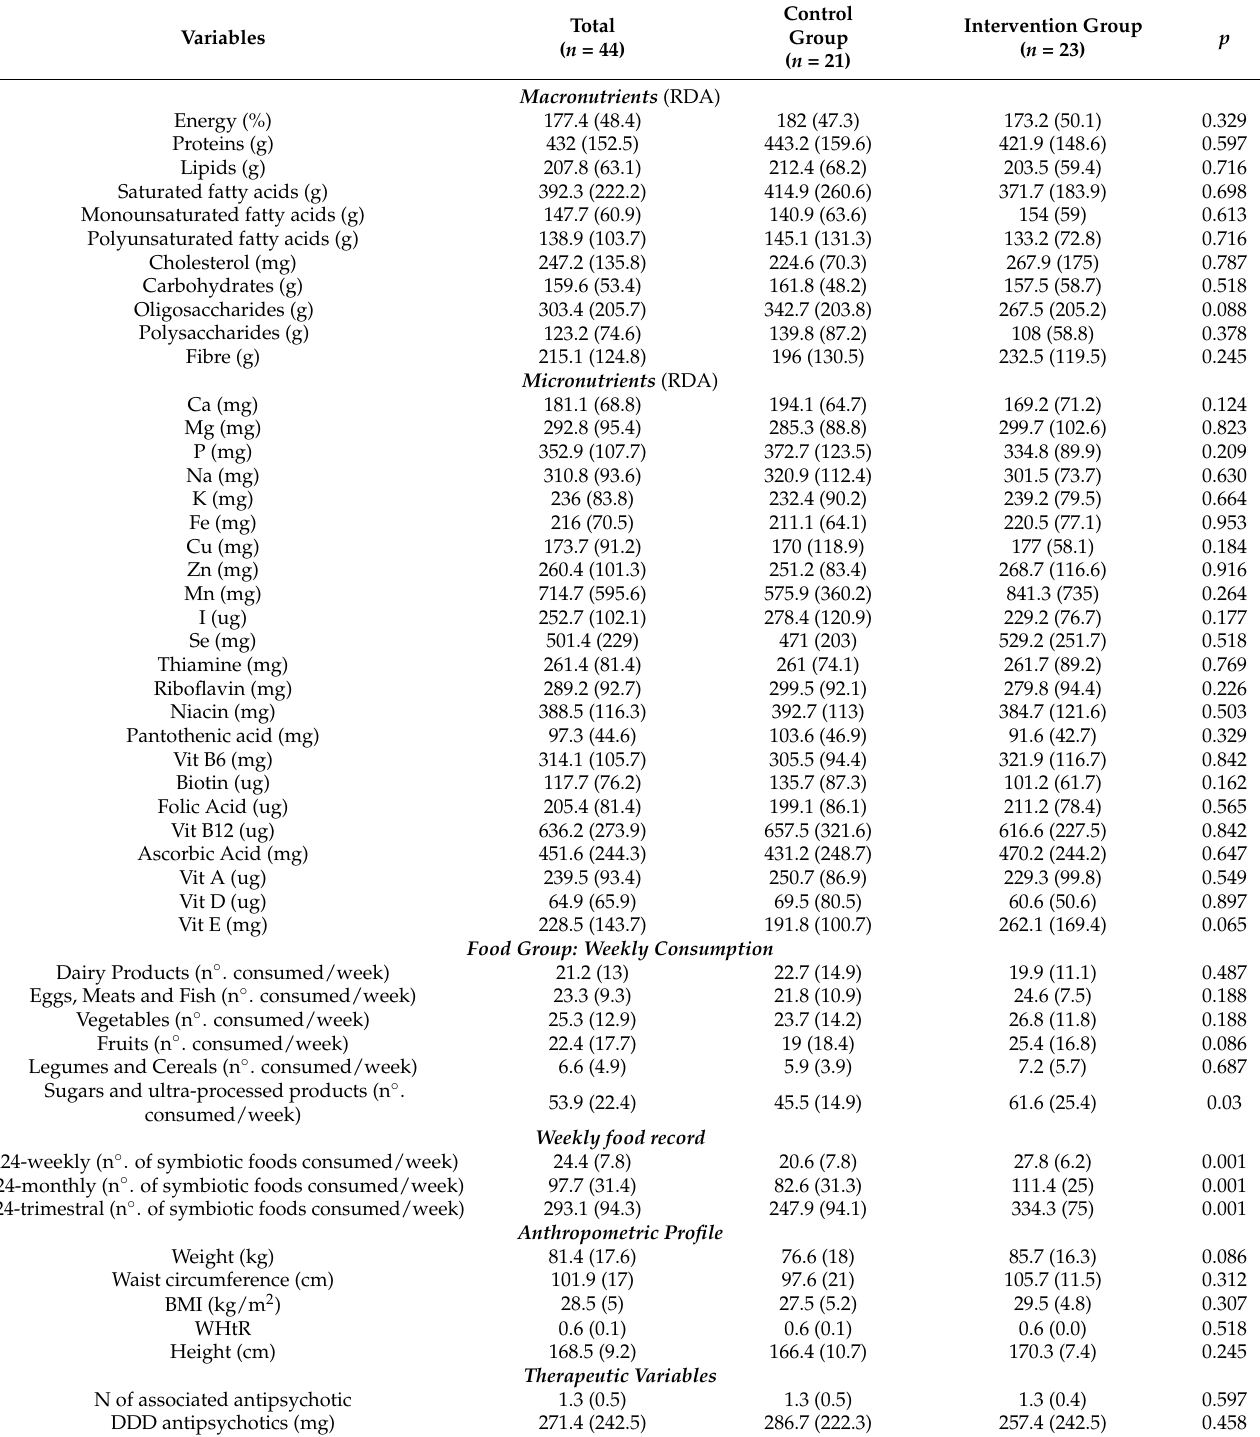
Table 2. Sample characteristics (dependent variables):